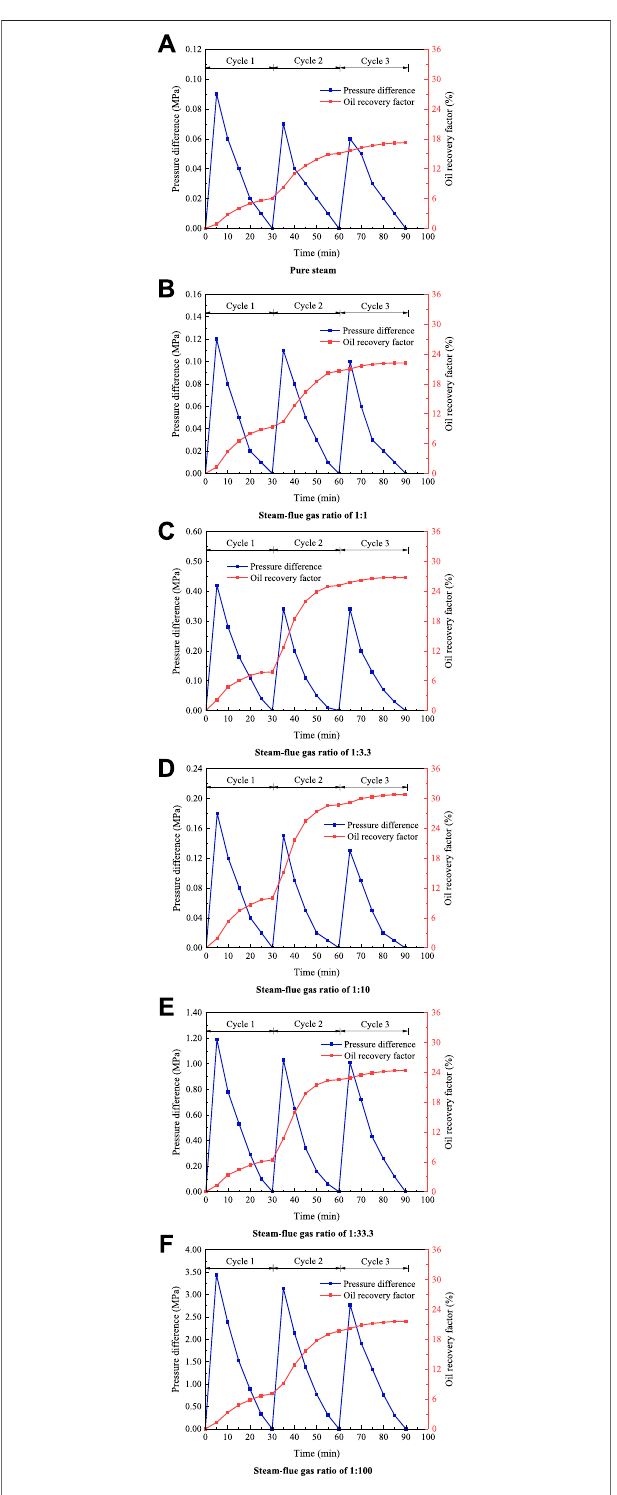
FIGURE 6 | Changes in backpressure and oil recovery factor with time. (A) Pure steam. (B) Steam- fl ue gas ratio of 1:1. (C) Steam- fl ue gas ratio of 1: 3.3. (D) Steam- fl ue gas ratio of 1:10. (E) Steam- fl ue gas ratio of 1:33.3. (F) Steam- fl ue gas ratio of